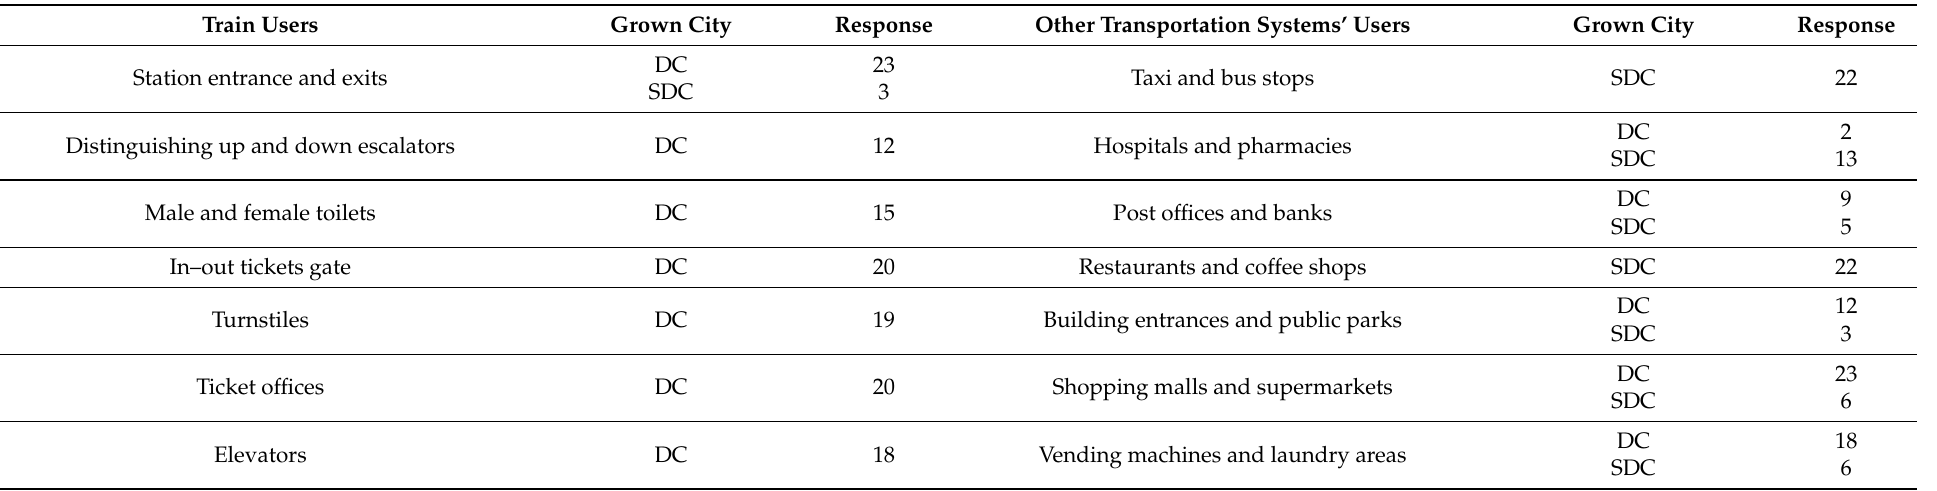
Table 4. Hopes regarding installation of auditory cues at different